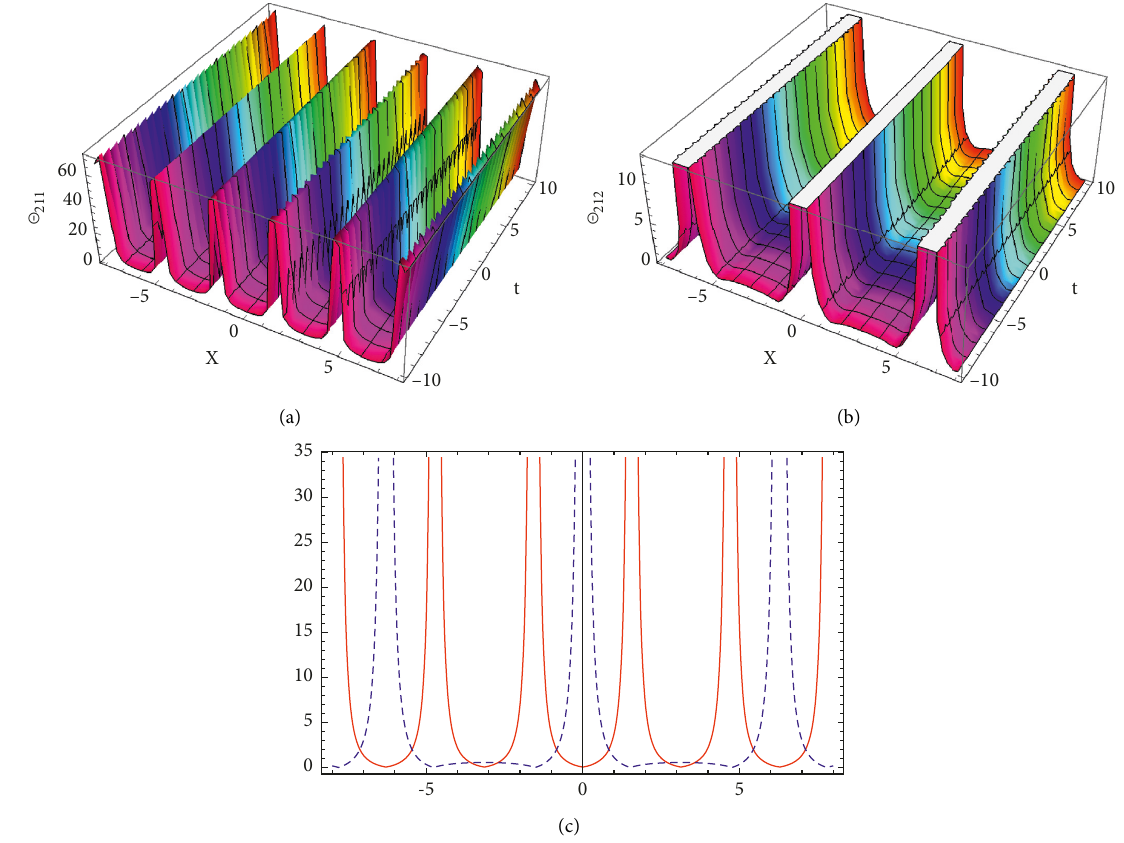
Figure 4: Plots of equations (56) and (57) for m � 2, ξ � 0 . 3, λ